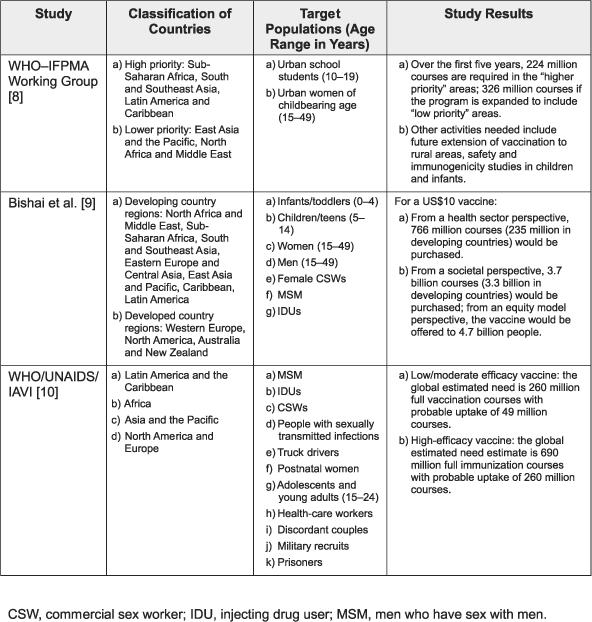
Results from Global Public Sector Demand Studies